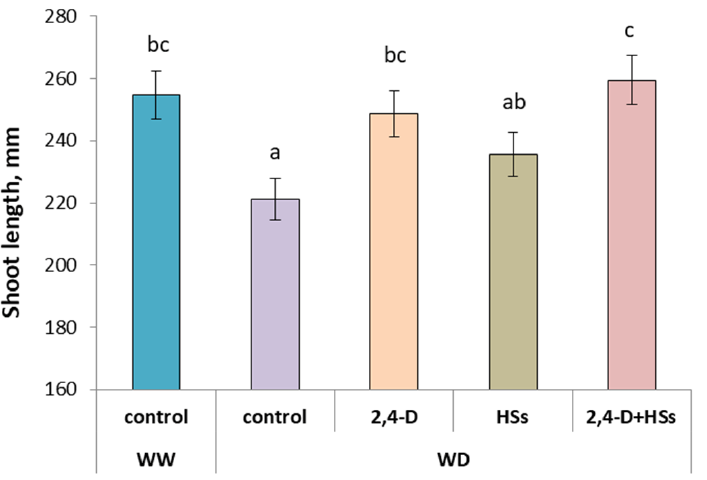
Figure 1. Shoot length of wheat plants 14 days after treatment with Pseudomonas plecoglossicida 2,4 ‐ D (2,4 ‐ D), humic substances (HSs) and their combinations (2,4 ‐ D + HSs) under well ‐ watering (WW) and water deficit (WD) conditions. Statistically different means are marked with different letters, p ≤ 0.05, n = 15 (ANOVA followed by Duncan’s test).